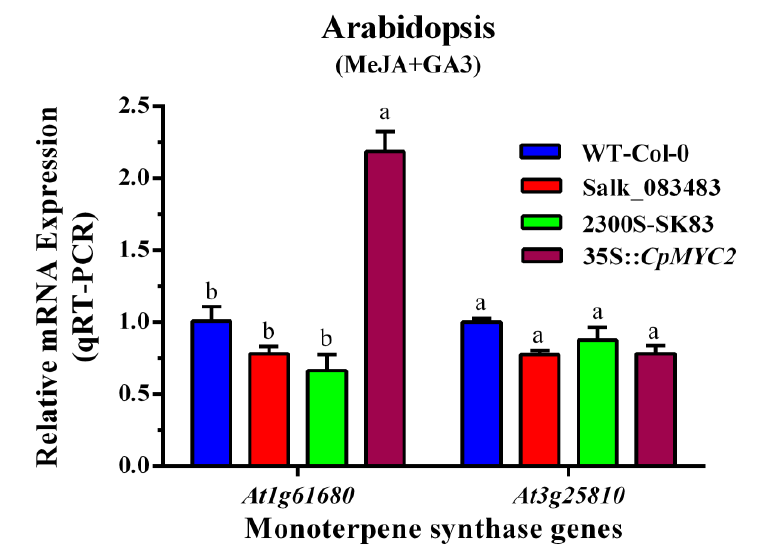
Figure 11. Expression of the monoterpene synthase genes At1g61680 and At3g25810 in arabidopsis plants by qRT-PCR after the application of MeJA and GA3 in arabidopsis wild type (WT-Col-0), mutant (Salk_083483), mutant Salk_083483 transformed by the empty vector pCAMBIA2300S (2300S-Sk83), and CpMYC2 gene (35S:: CpMYC2 ) plants measured by qRT-PCR. The different letters on the bars show significance between the treatments by using least significant difference (LSD) at p < 0.05.